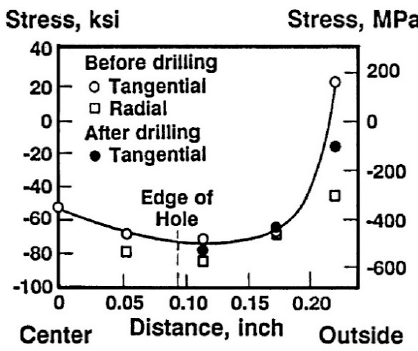
Figure 11. The first residual stress measurements on laser shocked 7075-T651, 5 GW/cm 2 , 3 mm quartz and black paint overlays, 11 mm spot diameter, 6 mm-thick specimens (0.1 inches = 2.5 mm) [29].